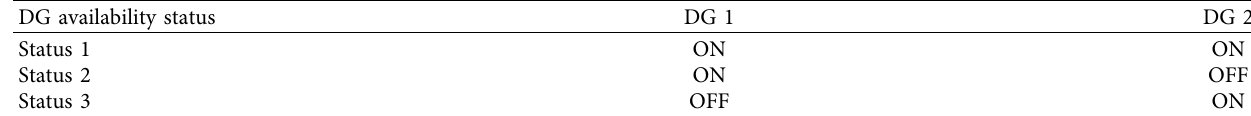
Figure 10: The modified distribution portion of the IEEE 14-node test feeder. Table 2: Available operating status of DGs for the microgrid.